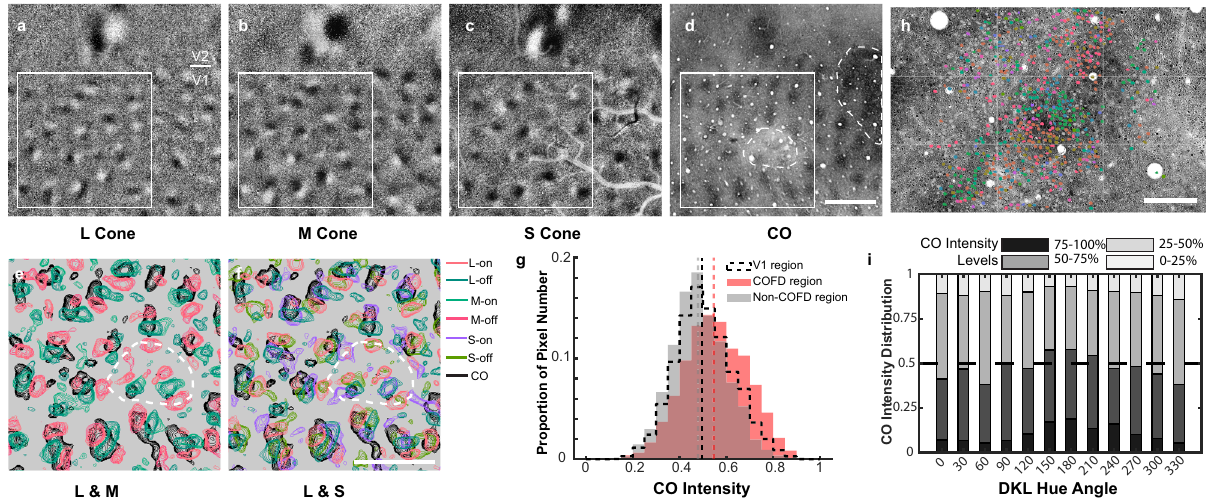
Fig. 7 | Spatialrelationshipbetween COFDsand CO blobs. a – c L-( a ), M- ( b ),and S-cone( c )COFDmapsofV1andV2fromanimalA5. d COimageafteralignment.Itis thesameregionshownin a – c .Scalebarin d :1mm;appliesto a – d . e , f Zoom-inview of the COFD and CO contours from the region within the white square shown in a – d .MorecasesareshowninSupplementaryFig.7a.Scalebarin f :1mm;appliesto e and f . g HistogramofCOintensitydistributionsinCOFD,non-COFDandwholeV1 regions. Dashed lines are median of the distribution in each region. The CO intensitydistributioninCOFDregionsissigni fi cantlyhigherthanthatinnon-COFD regions ( n =96 COFD regions, P =0.0062, Wilcoxon signed rank test, two-sided). Note that dotted white outline in d – f indicates region restricted from